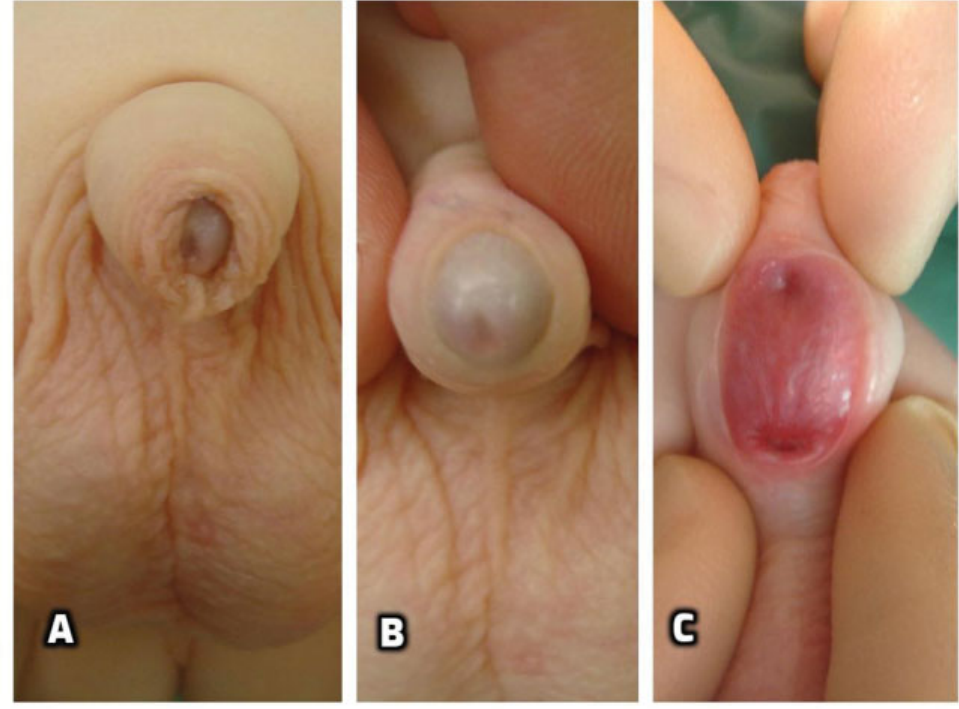
Fig. 1 Congenital anterior urethrocutaneous fi stula (CAUF) with a large fi stula: preoperative examination showed complete foreskin ( A ), normal glans with a wide orthotopic meatus ( B ), and a persistent urethral groove with two openings communicating to distal (arrow head) and proximal (arrow) urethra ( C ).